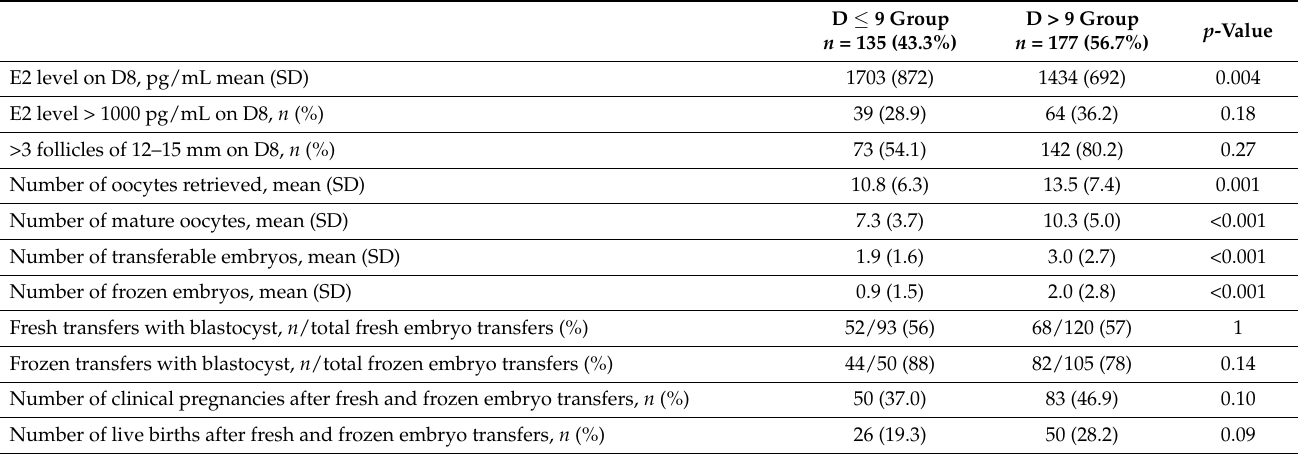
Table 2. IVF/ICSI outcomes according to the day of ovulation trigger.